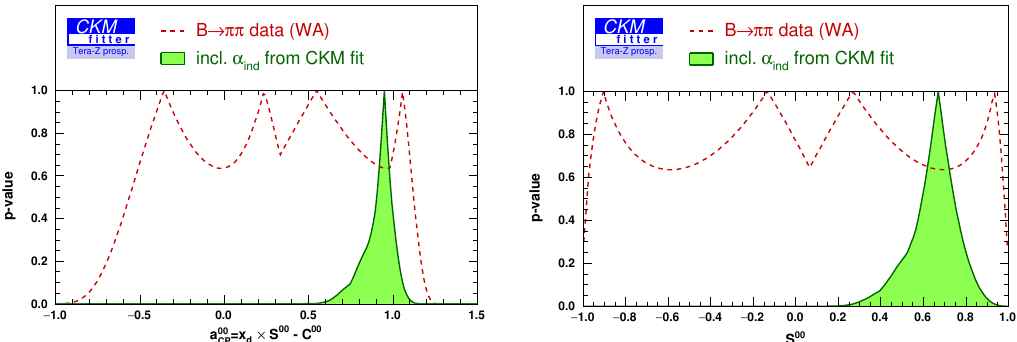
(left) and S 00 (right) from current B → ππ data alone (dashed red) and Figure 13 . p -values for a 00 CP CP the global fit (solid green). The latter yields the predictions a 00 (as well as C 00 = − 0 . 43 +0 . 12 ). − 0 . 09 CP